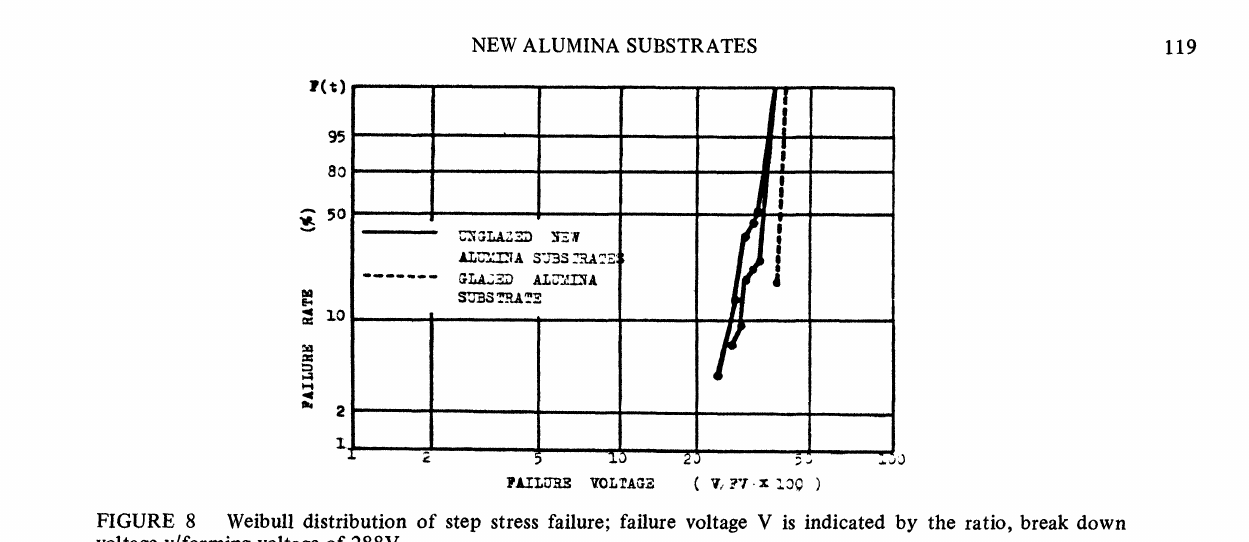
Weibull distribution of step stress failure; failure voltage V is indicated by the ratio, break down voltage v/forming voltage of